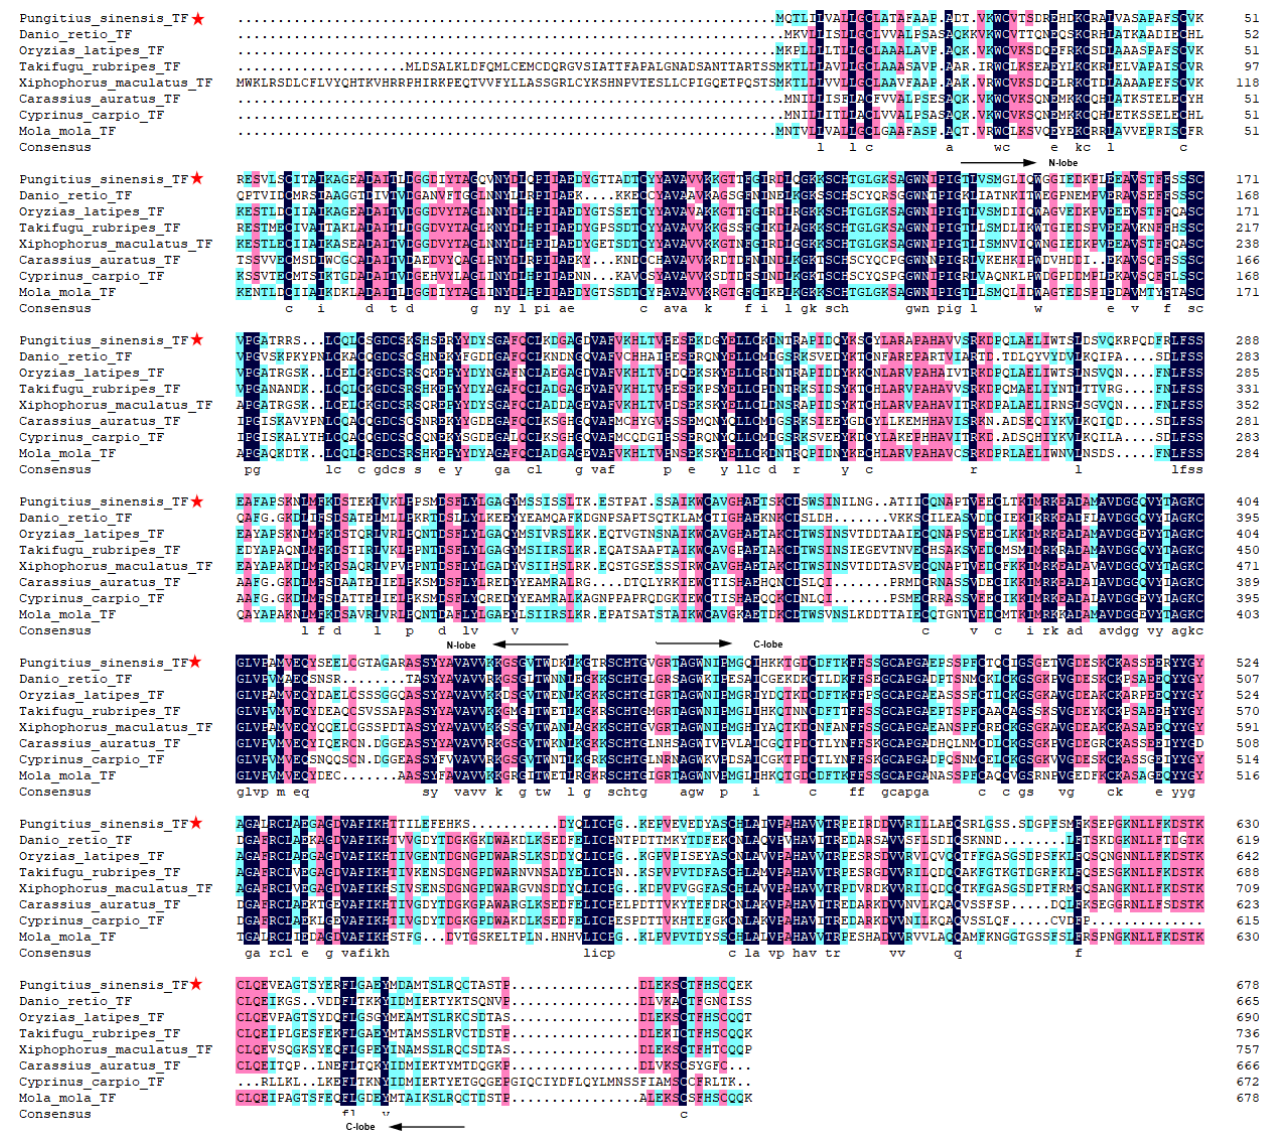
Figure 1. Alignment of transferrin amino acid sequences between P. sinensis (marked with red asterisks) and other seven fish species randomly selected. The N-lobe and C-lobe areas are marked with arrows.